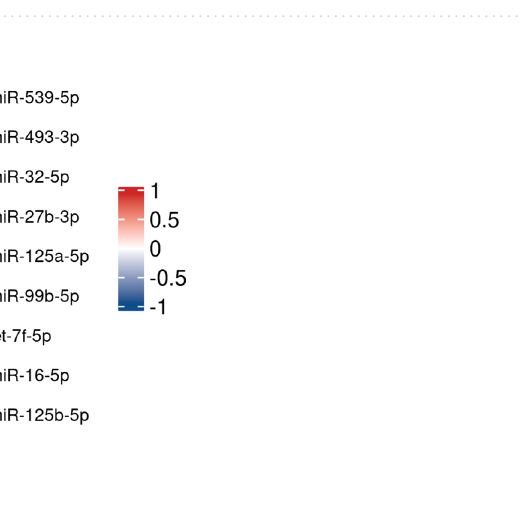
Figure 3. Hierarchical clustering of the differentially expressed miRNAs after treatment with cfDNA healthy, cfDNA T1/T2, and cfDNA T3/T4 using NanoString nCounter miRNA Expression Assays. Red: up-regulated, blue: down-regulated. (padj < 0.05, ANOVA; FC >